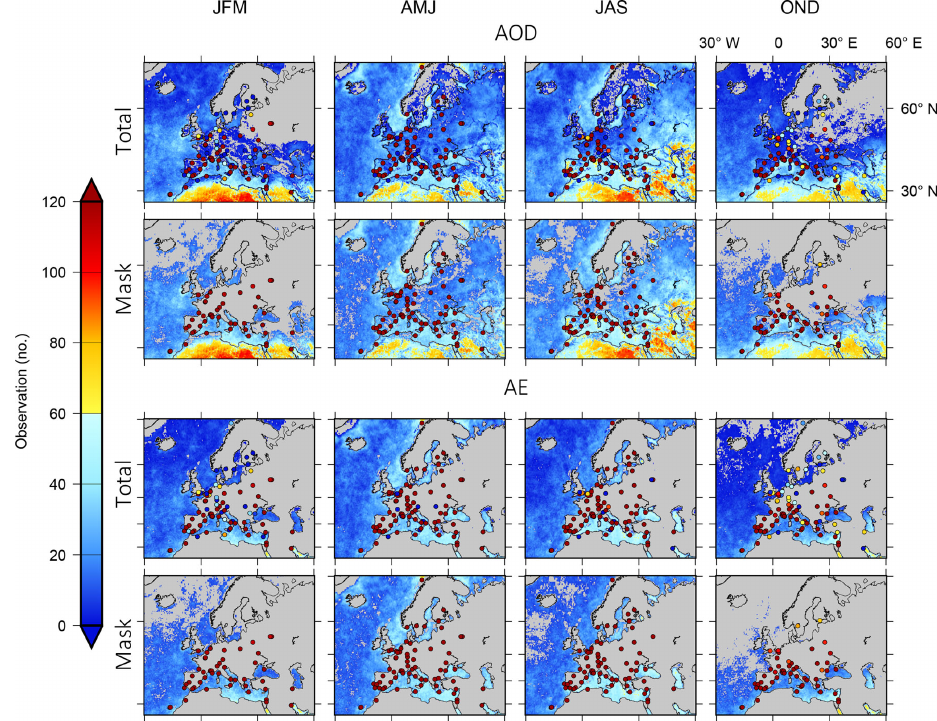
Figure 1. Total and under-the-mask number of observations used in the analysis. Maps show the number of MODIS observations and point out the number of AERONET